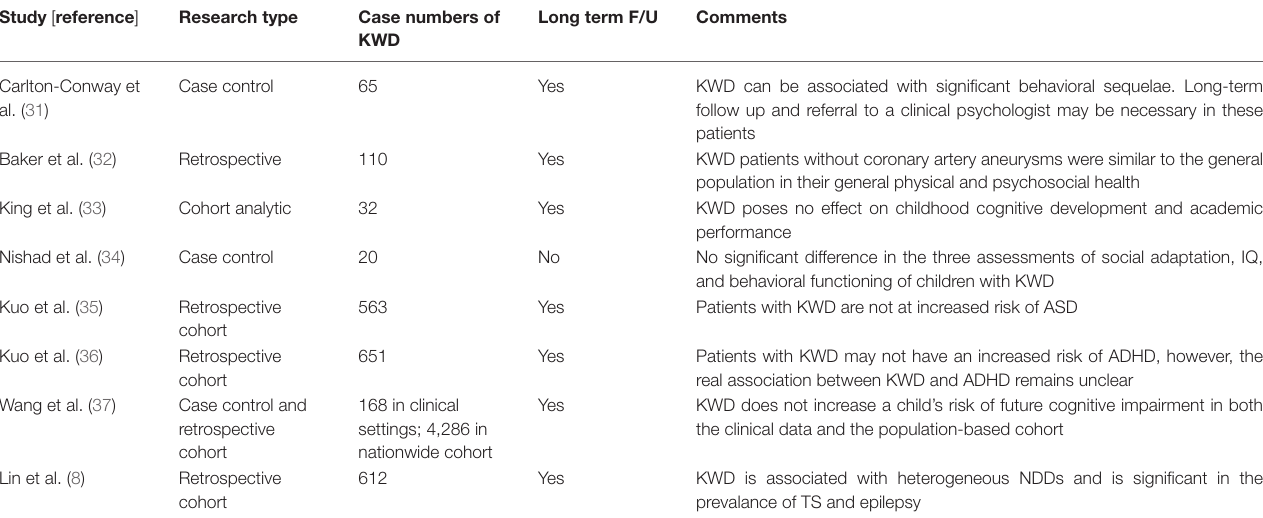
TABLE 5 | Literature search and article analysis for neurodevelopmental disorders in children with